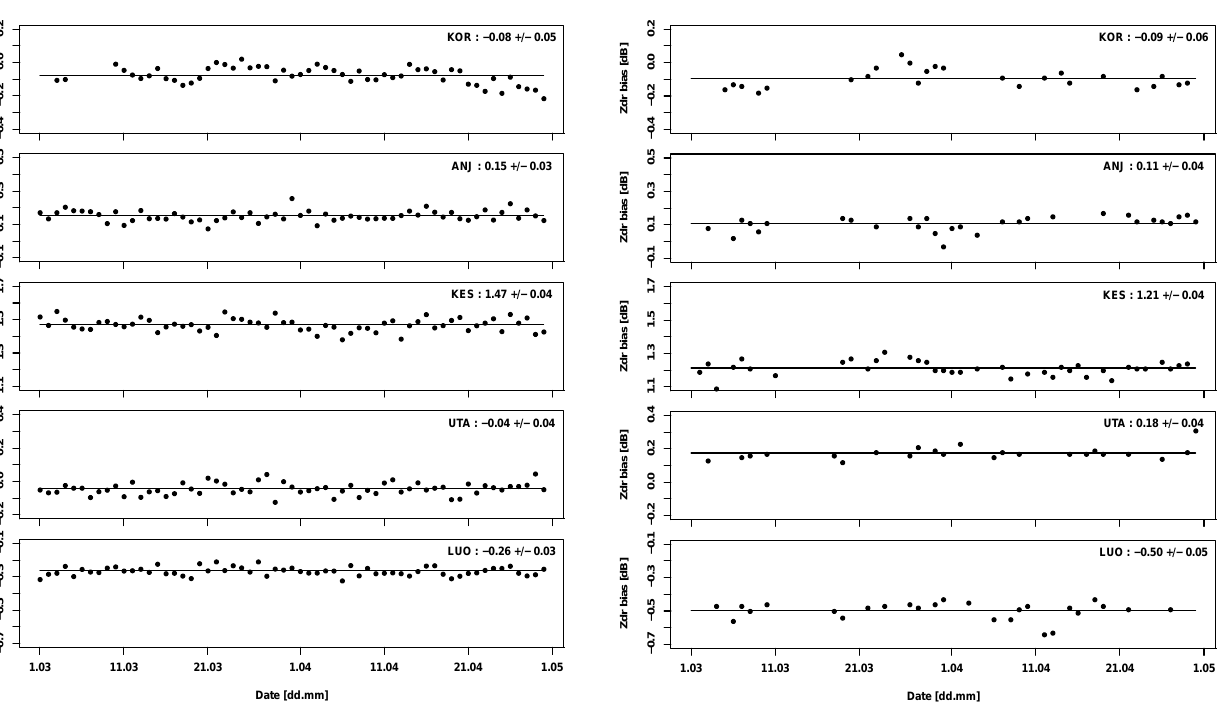
Figure 9. Z dr results in rainfall from the zenith scan for March and April 2015 for FMI radars indicated in the panels. The numbers in each panel give the mean and standard deviation for the data. For each radar the same vertical axis limits as in Fig. 8 are